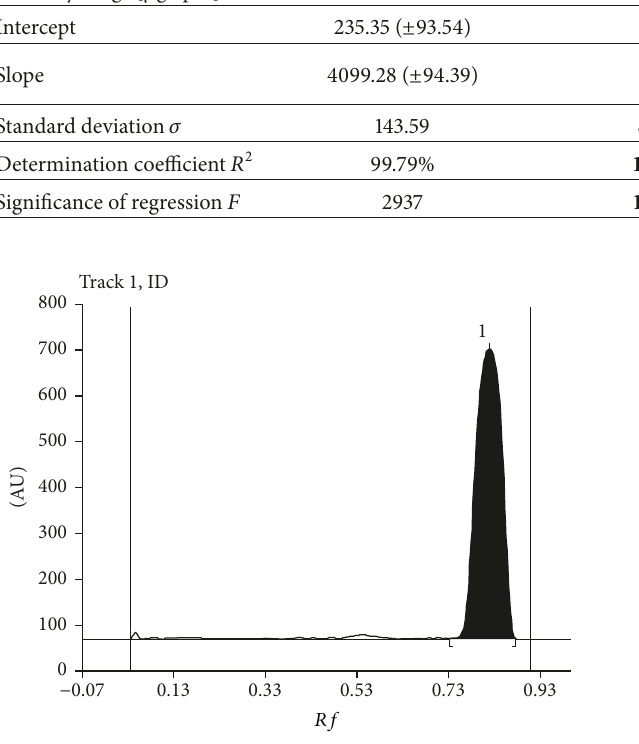
Figure 2: Densitogram of initial solution of diphenhydramine, 𝜆 = 200 nm; 𝑅 = 0.82 . 𝐹 max